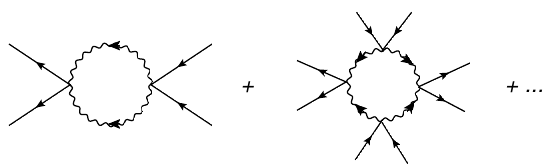
Figure 3 . The e(cid:11)ective coupling of the vector model obtained by integrating out the tensor (cid:12)elds. Notice that a similar 6-point e(cid:11)ective coupling is not generated due to the form of the interaction